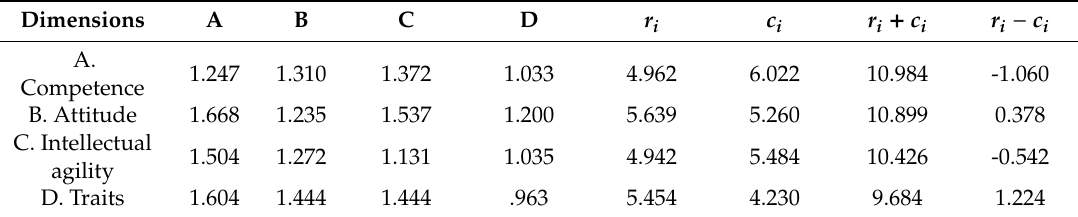
Table 6. Total relation matrix ( T D ) and derived Prominence and Relation of dimensions.